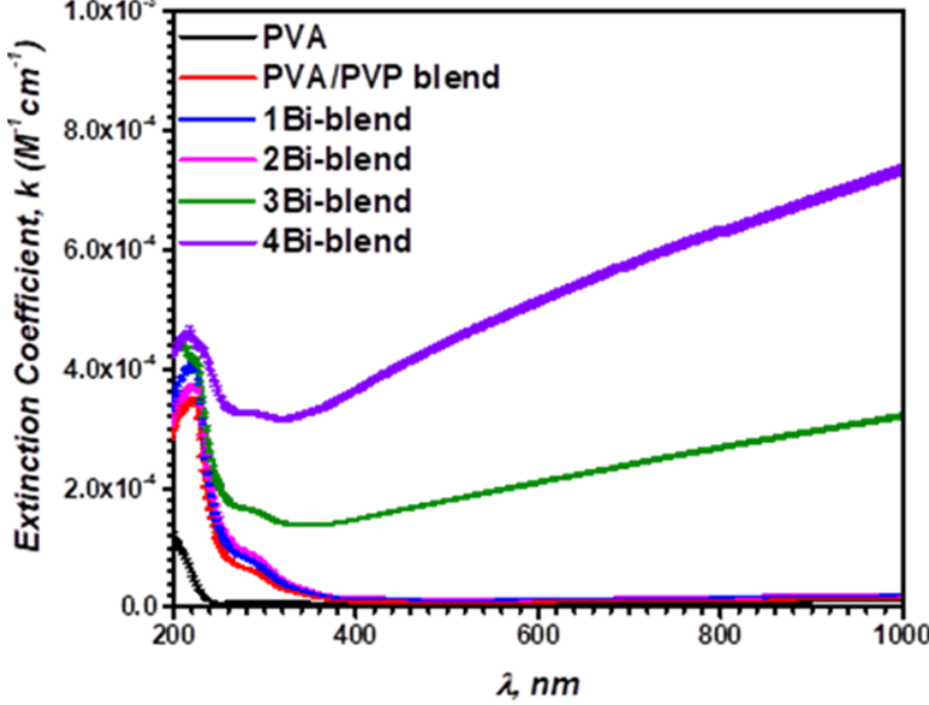
Figure 11. Variation of extinction ( k ) coefficient versus the photon wavelength ( λ ) of pristine PVP/PVA blend, and Bi-blend hybrid films.